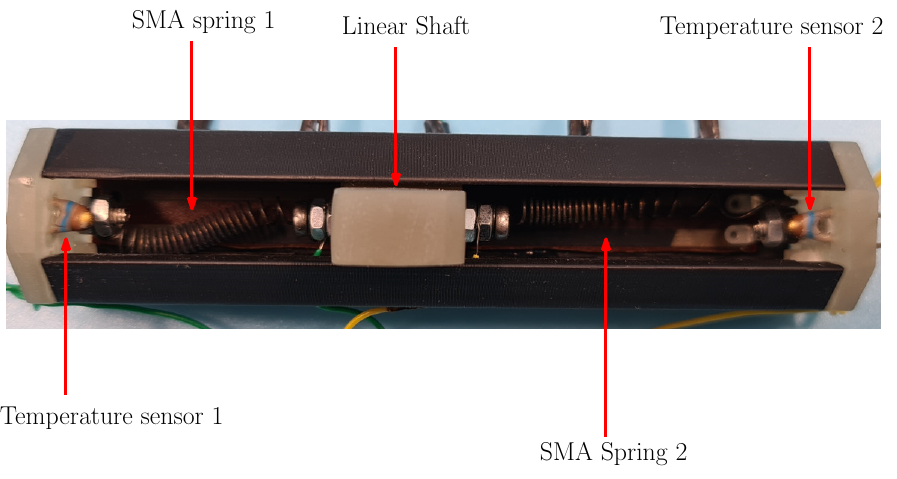
Figure 13. Upper view of the SMA linear actuator structure.